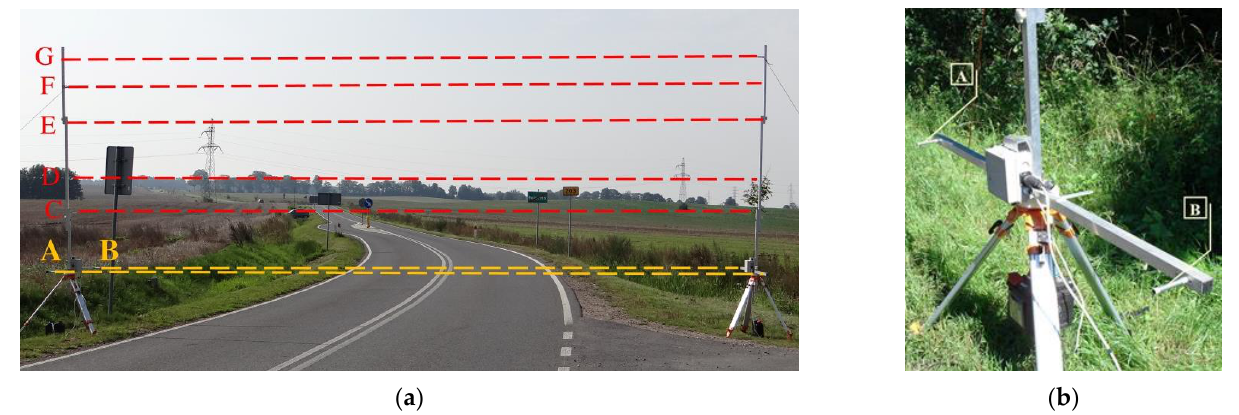
Figure 6. The speed measuring device employed in traffic count and speed survey: ( a ) Schematic representation of the elevations of the sensors for the automatic traffic count and vehicle classification survey: C, D, E, F and G; ( b ) speed sensors A and B. Source: own work of the authors.